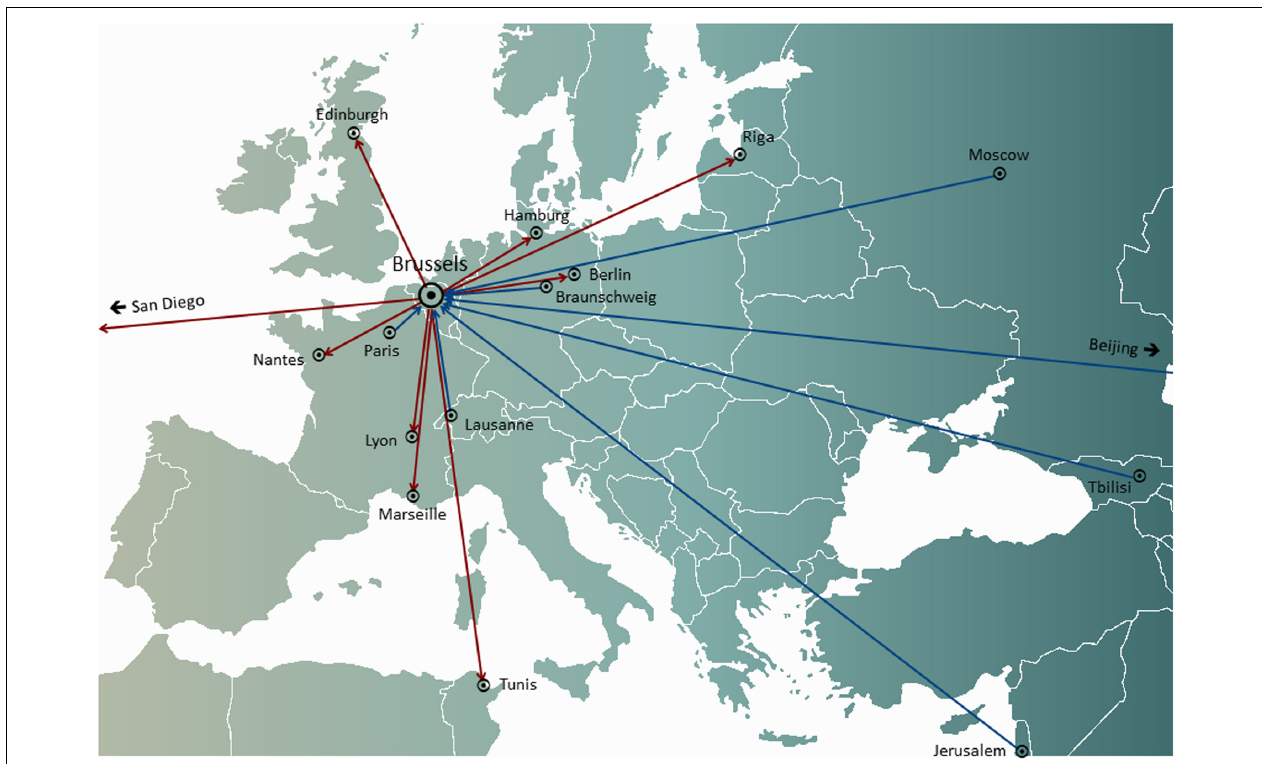
FIGURE 1 | International transfers of phages from (red arrows) and to (blue arrows) the Queen Astrid Military Hospital (QAMH) in Brussels in view of clinical applications over the period 2015–2020. On the national level, phages were dispatched from the QAMH to five university hospitals (not shown). In addition, the selection of matching phages often encompassed the transfer of the patients’ bacterial isolates, and five international patients (two from France, two from the Netherlands, and one from Tunisia) were transferred to Brussels for phage